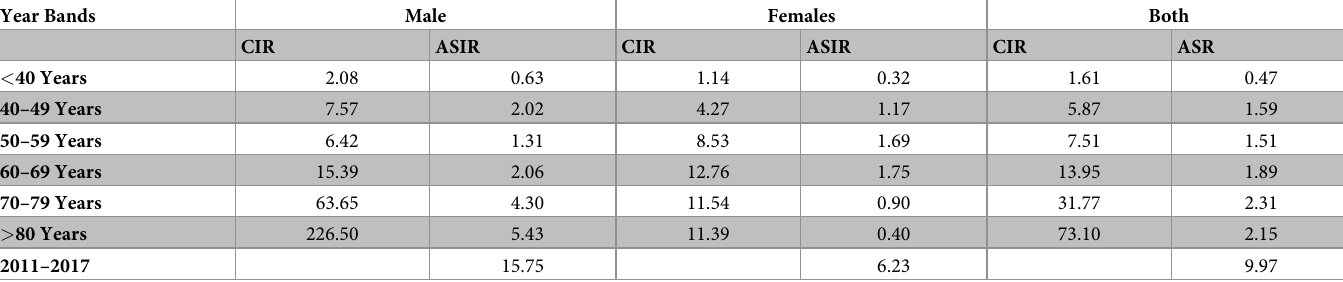
Table 2. Seven year age standardised incidence rates and crude incidence rates of colorectal cancer by age groups for both sexes (per 100 000 population). Year